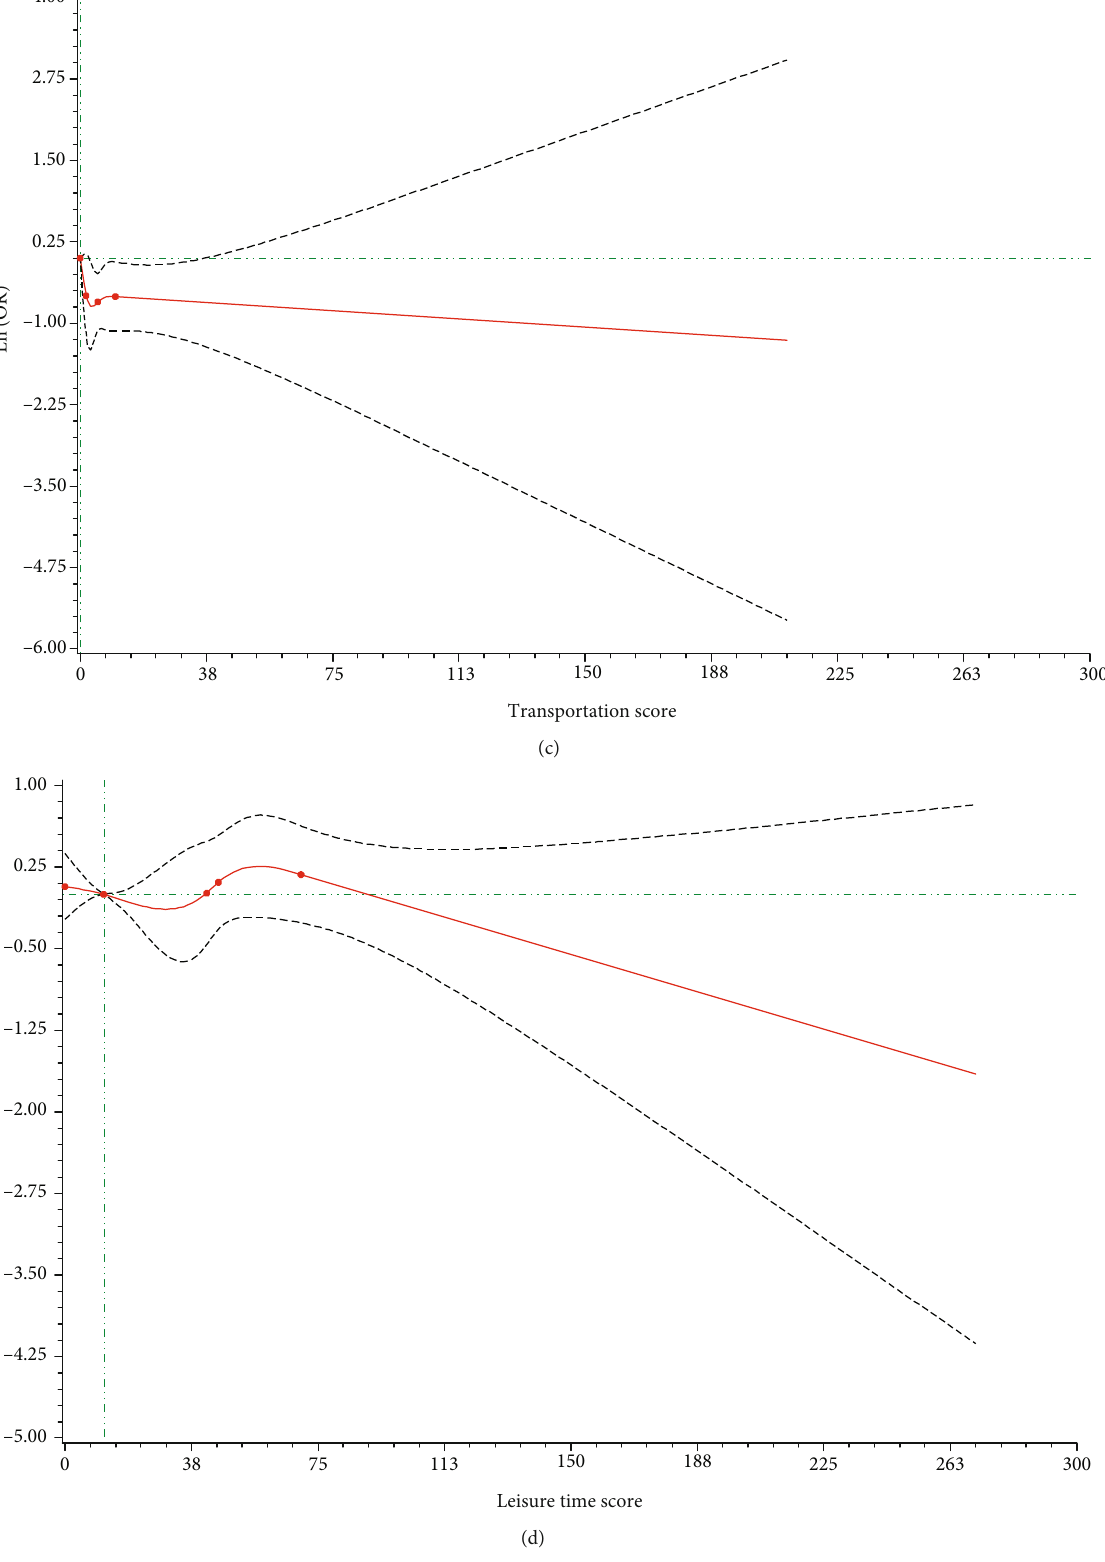
Figure 2: The RCS results between scores of (a) domestic, (b) occupational, (c) transportation, and (d) leisure time activities and cognitive function